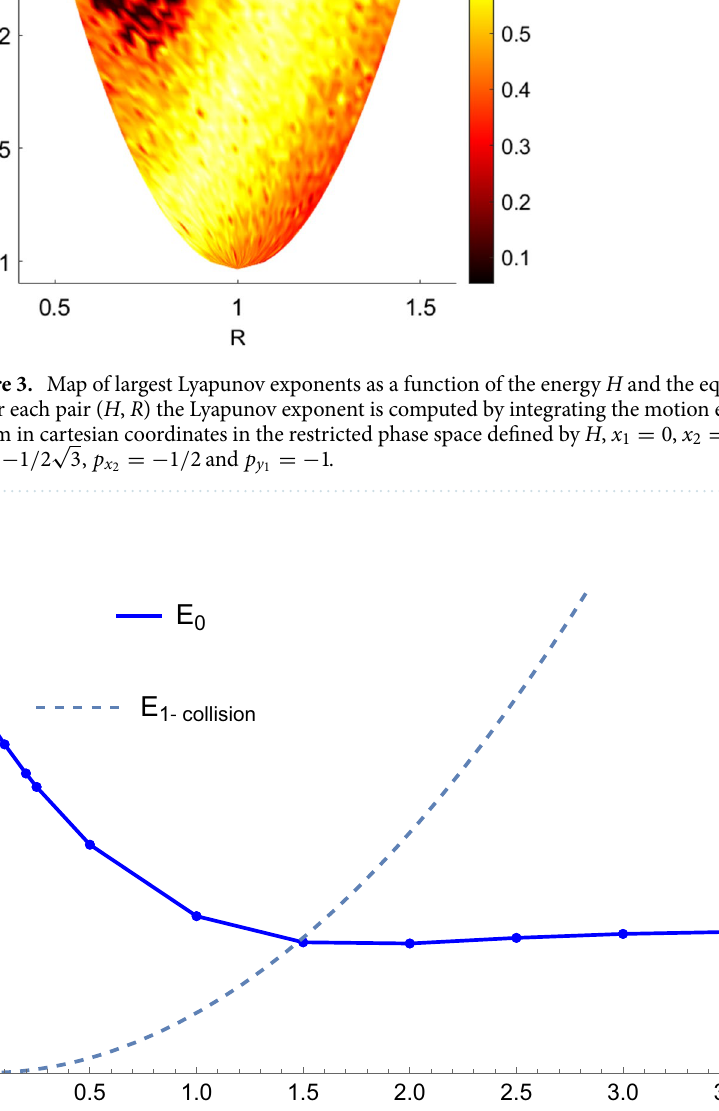
Figure 4. Ground state energy E 0 (a.u.) of the quantum TBHO vs R (a.u.) at d = 3 . The solid line corresponds to an interpolation of the numerical results marked by dots whilst the dashed line refers to the classical critical value E 1 − collision below which no collisions occur. The parameters m 1 = m 2 = m 3 = 1 , ν 12 = ν 13 = ν 23 = 3 4 and ω = 1 were